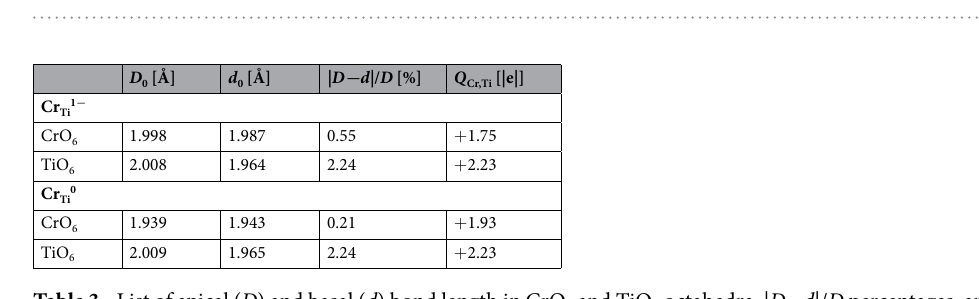
Table 2. List of lattice parameters, bond lengths, energy band gap and Bader effective charge calculated for the rutile phase. Comparison to experimental data and other theoretical studies are included. a Previous work (ref. 30 ); b ref. 39,48–50 ; c ref. 33,44,51 .